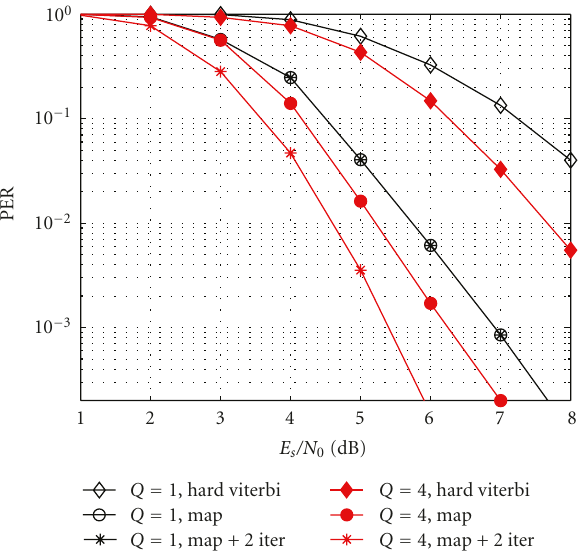
Figure 3: Configuration 1: 20MHz, CDD ( N T = 4, N s = 1, N R = 1), 16-QAM modulation. PER performance with (solid markers) and without (hollow markers) GO-CDM.